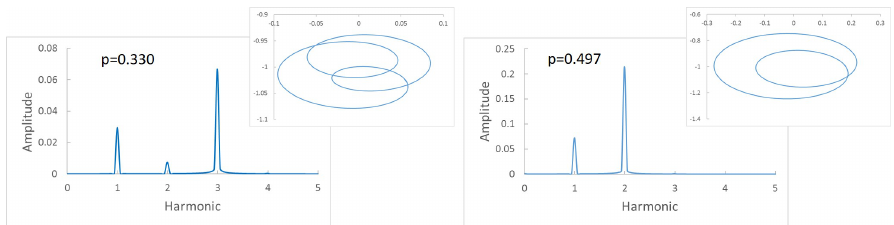
Figure 6. Frequency spectrum of a cracked shaft: α = 0.2, p = 0.330, and p = 0.497.